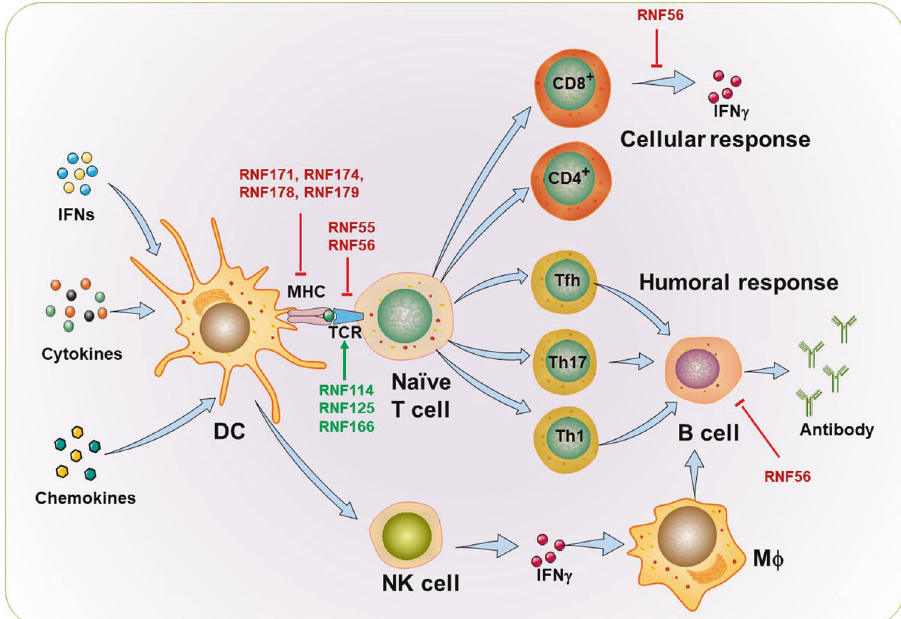
Fig. 6 RNF proteins orchestrate the adaptive immune responses. After the innate immune responses, the DCs are activated by IFNs-induced cytokines and chemokines and then ef fi ciently present the antigens to naive T cells via a combination of MHC and TCR. Naive T cells differentiate into several subtypes with unique functions in triggering and regulating T-cell-dependent cellular immune responses and B-cell- mediated antibody